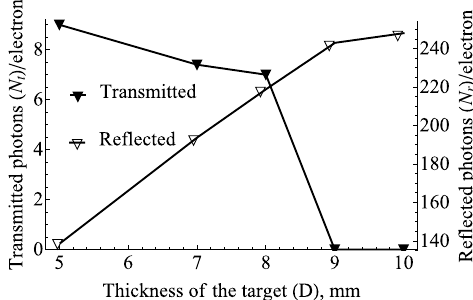
Fig. 4. Dependence of the number of transmitted and re°ected photons on the thickness of the target ( E 0 e ¼ 1 : 9 MeV, (cid:2) ¼